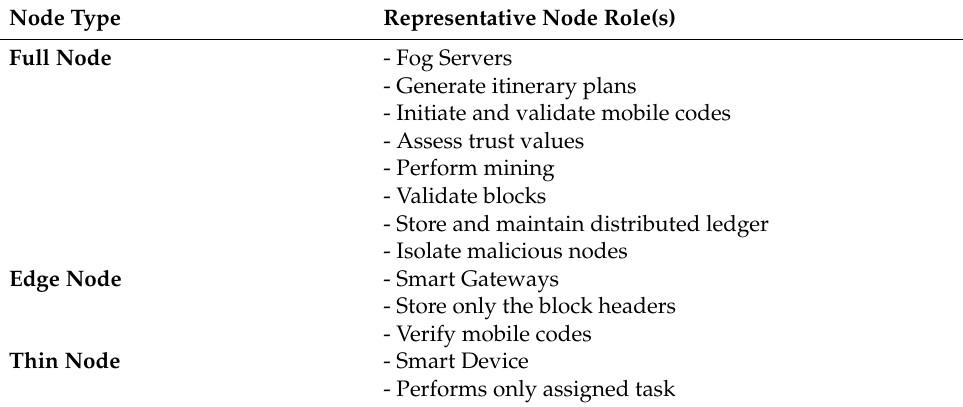
Table 2. Types of nodes in proposed system